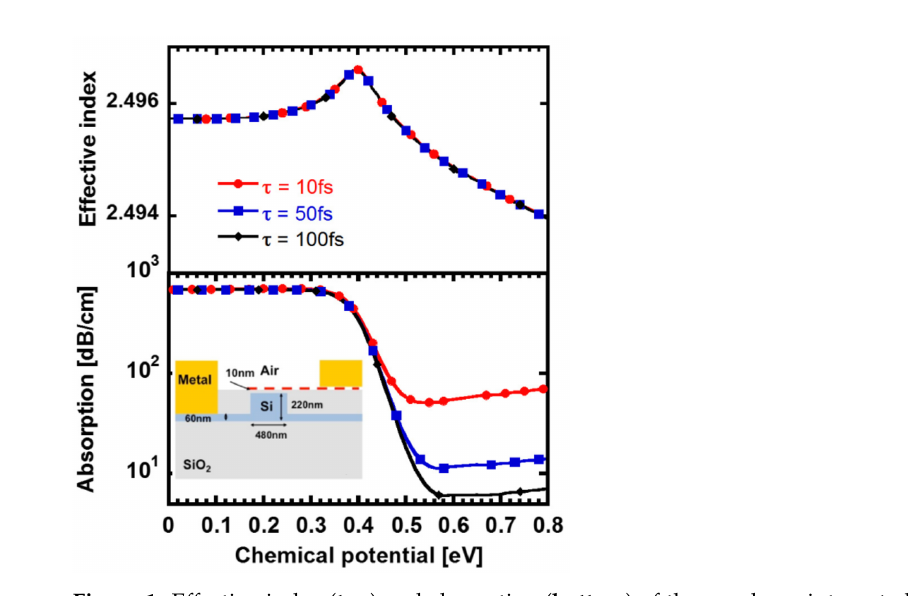
Figure 1. Effective index ( top ) and absorption ( bottom ) of the graphene-integrated Si waveguide at 1.55 µ m versus chemical potential in graphene, the intra-band relaxation time τ represent dif- ferent graphene qualities. Inset: the cross-section of silicon-based graphene waveguide used in calculations [46]. Reproduced from [46] with